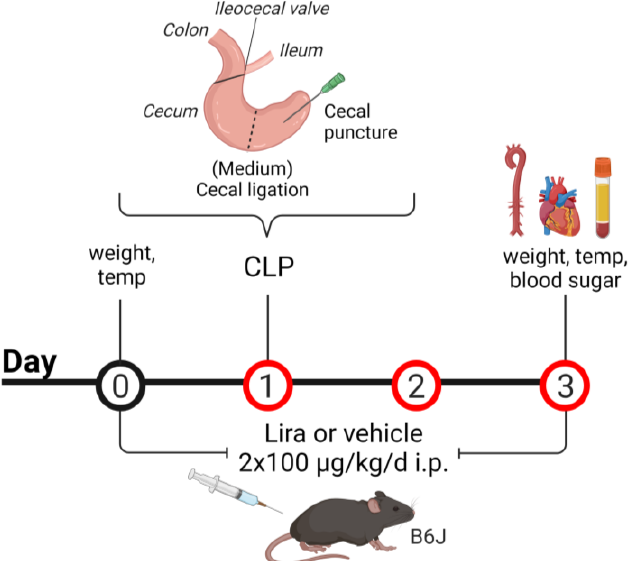
Figure 1. Scheme for treatment and cecal ligation and puncture (CLP) procedure. Male C57BL/6J mice were treated with liraglutide (Lira) or the vehicle (saline) twice daily, every 12 h, for 3 consecutive days via intraperitoneal injections (i.p.) at a dose of 2 × 100 µg/kg/d for Lira or an adequate volume of the vehicle. One day after initial administration, a mid-grade polymicrobial sepsis was induced by cecal ligation at the medium position below the ileocecal valve, followed by needle perforation (puncture) of the cecum. Created with BioRender.com.